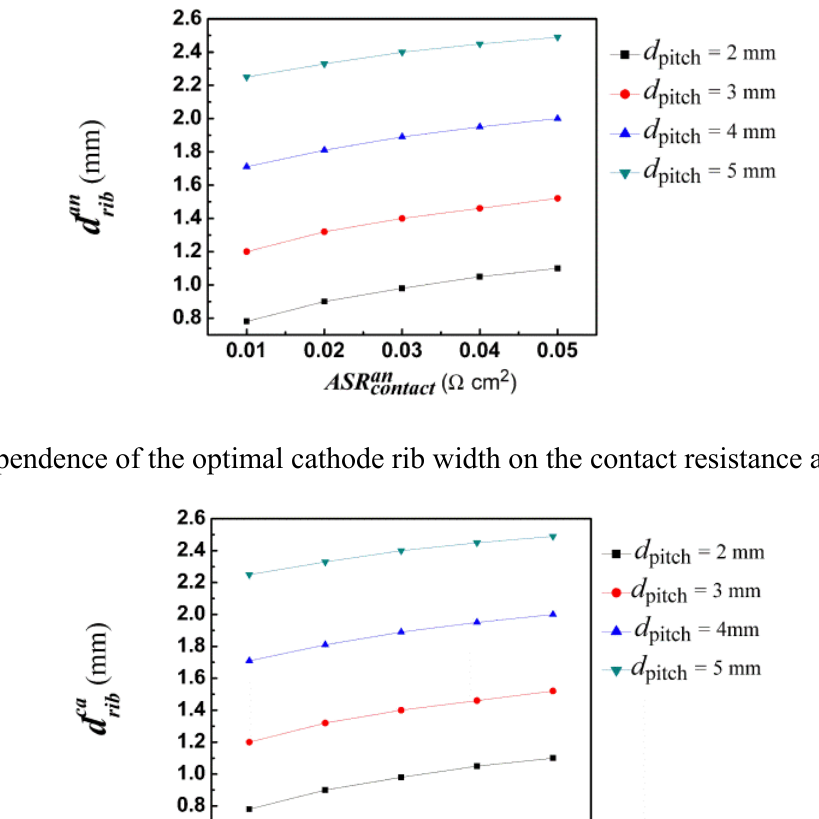
Figure 5. Dependence of the optimal anode rib width on the contact resistance and pitch width.